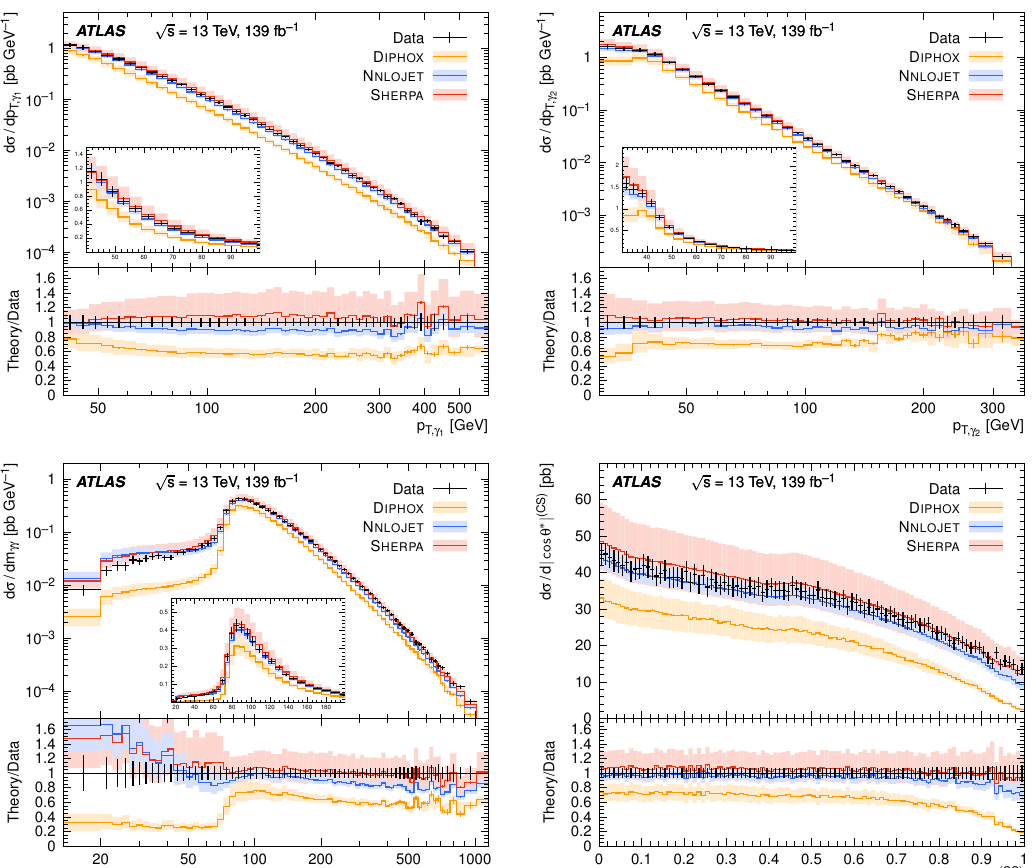
, p , m and | cos θ ∗ | (CS) T ,γ 2 γγ 1 , p and m the last bin is only T ,γ 1 T ,γ 2 γγ